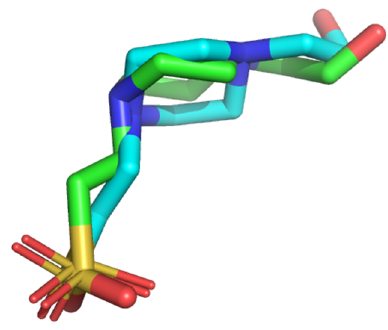
Figure 5. The pose generated for the superimposition of the co-crystallized HEPES molecule (sky blue) and the re-docked HEPES molecule (green). This supports AutoDock Vina as an effective docking protocol.